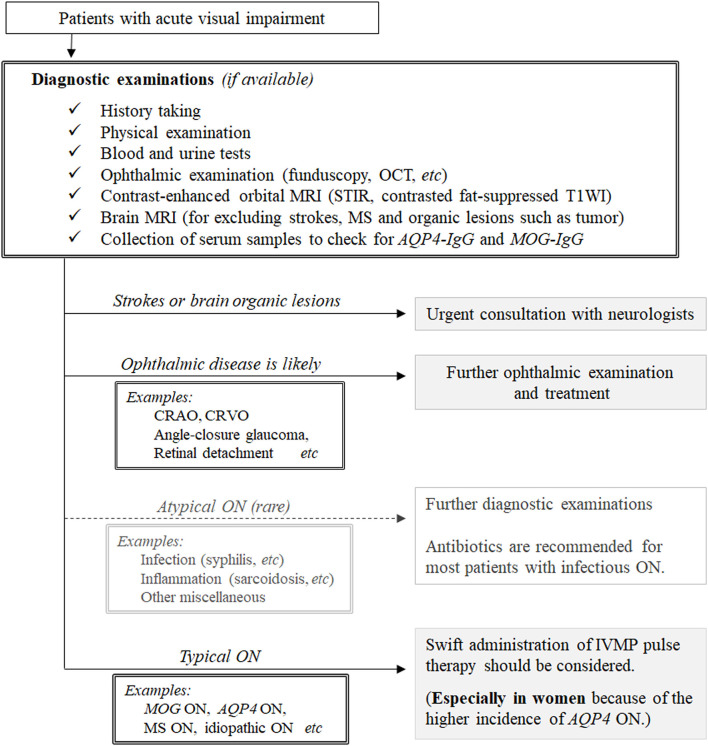
A conceivable therapeutic strategy for patients suspected of having optic neuritis. AQP4-IgG, anti-aquaporin-4 autoantibodies; CRAO, central retinal artery occlusion; CRVO, central retinal vein occlusion; DDx, differential diagnosis; HIV, human immunodeficiency virus; IVMP, intravenous methylprednisolone; MS, multiple sclerosis; MOG-IgG, anti-myelin oligodendrocyte glycoprotein antibody; ON, optic neuritis; STIR, short T1 inversion recovery; T1WI, T1-weighted imaging.